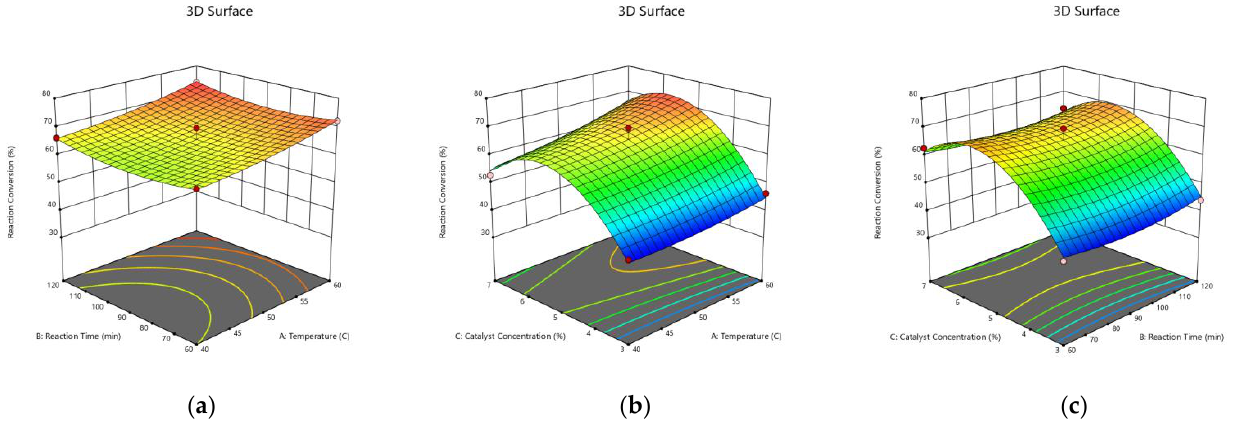
Figure 4. Three Dimensional (3D) Response Surface of the Effects of the Process Variables on the Reaction Conversion. ( a ) Catalyst Concentration of 5%; ( b ) Reaction Time of 90 min; ( c ) Reaction Temperature of 50 °C.